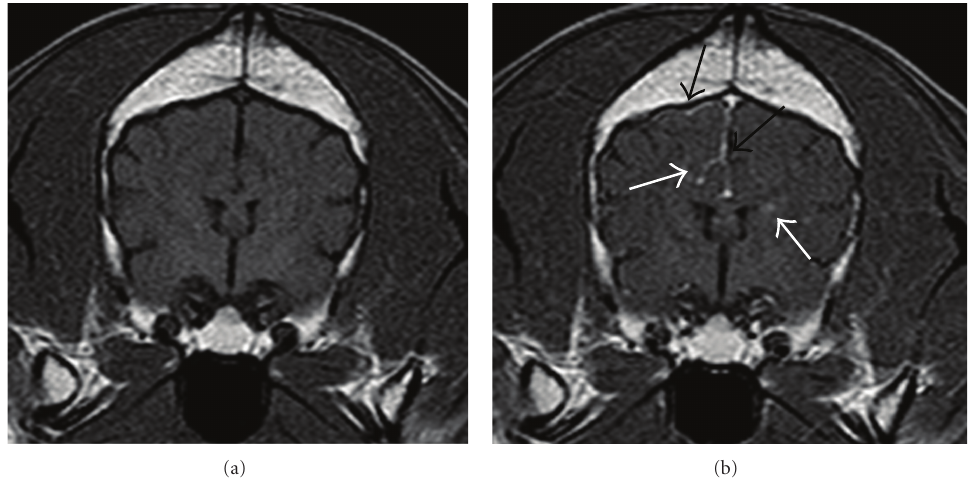
Figure 3: T1-weighted precontrast (a) TR = 588, TE = 15) and T1-weighted postcontrast (b) TR = 588, TE = 15) transverse plane images at the level of the rostral part of the 3rd ventricle in a dog with monocytic ehrlichial meningoencephalitis. There is contrast enhancement of the meninges (black arrows). There are a few subtle, poorly defined regions of contrast enhancing brain parenchyma (white arrows).